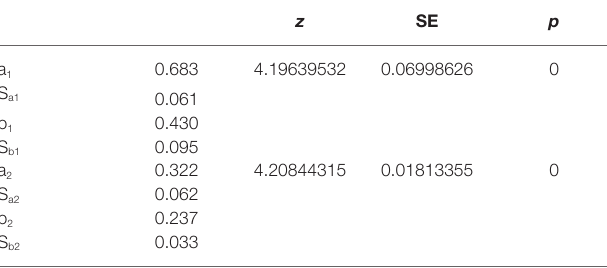
TABLE 6 | Sobel test results (model